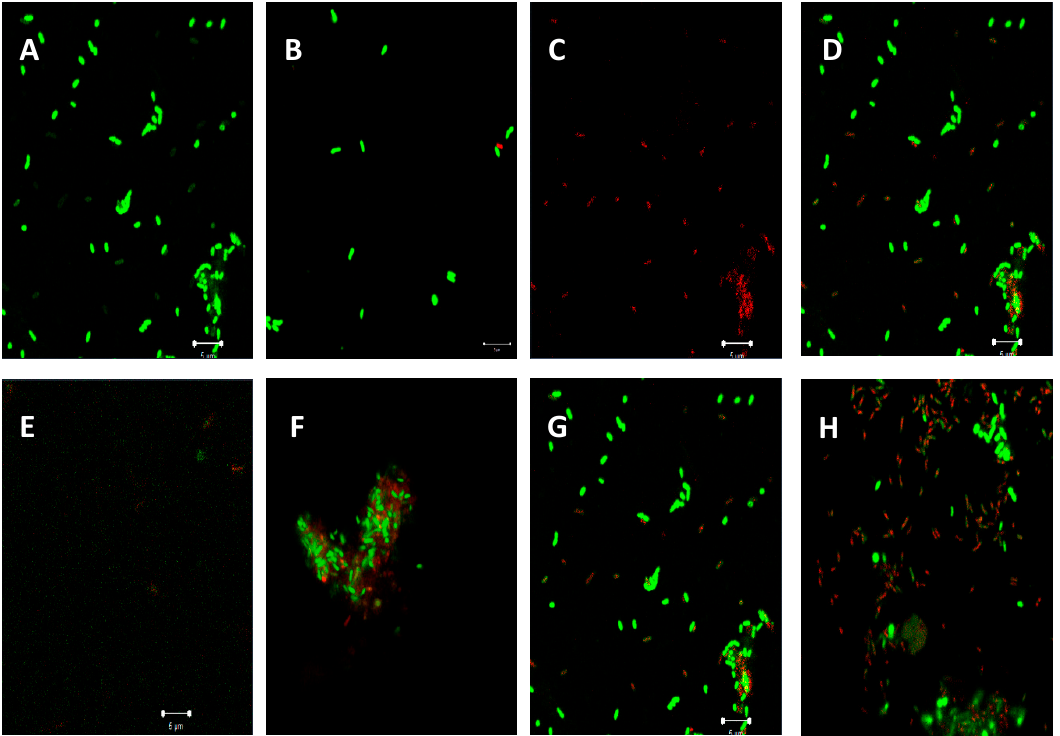
Figure 7. Observation of P. aeruginosa cells treated and untreated with test extracts of C. aurea ethanol, acetone, and ethyl acetate using confocal laser scanning microscopy (CLSM). ( A )— P. aeruginosa ATCC 9721 cells treated 1% DMSO, ( B )—Cells treated with C. aurea ethanol extract, ( C )—image showing dead cells only treated with C. aurea ethanol extract, and ( D )—Combination of live and dead cells treated with C. aurea ethanol extract. ( E )—Cells treated with ciprofloxacin (0.06 mg/mL). ( F ), ( G ), and ( H ) represent cells treated with ethanol, acetone, and ethyl acetate extracts, respectively. Live cells staining appear green, while dead cells show red fluorescence.